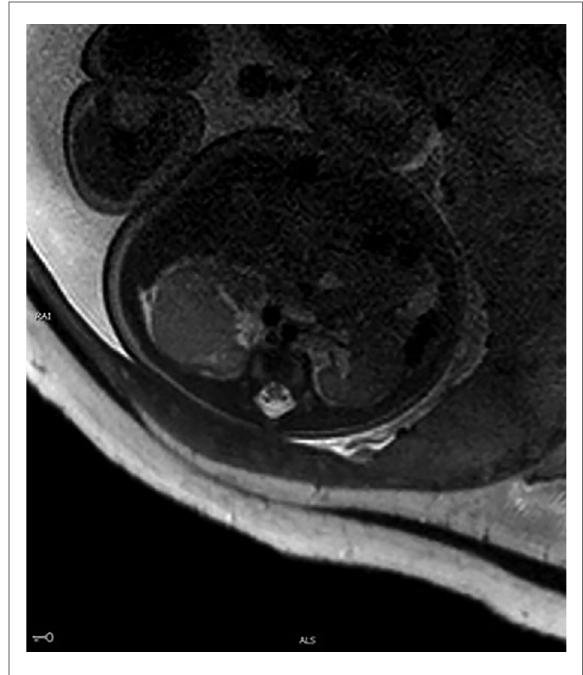
FIGURE 2 MRI of the foetus. A large, irregular mass (28 mm×25 mm×21 mm) was noted with isointense on T2WI.